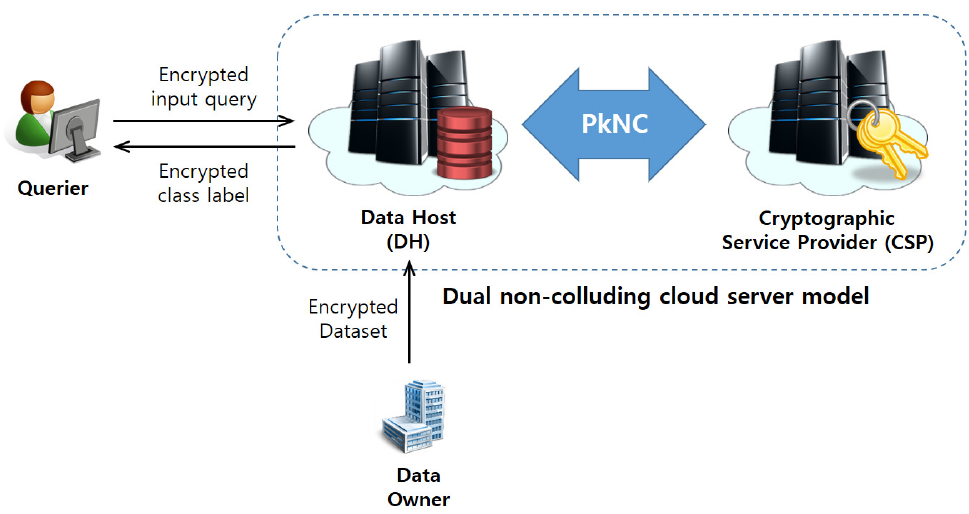
Figure 1. System model of P k